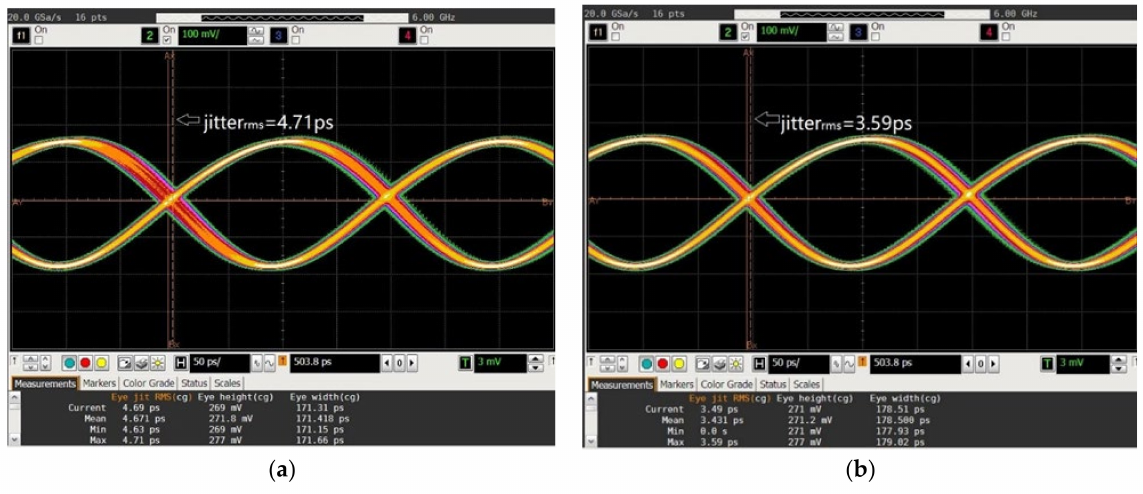
Figure 14. Test results of the eye diagram at 2.5GHz ( a ) without calibration; ( b ) with